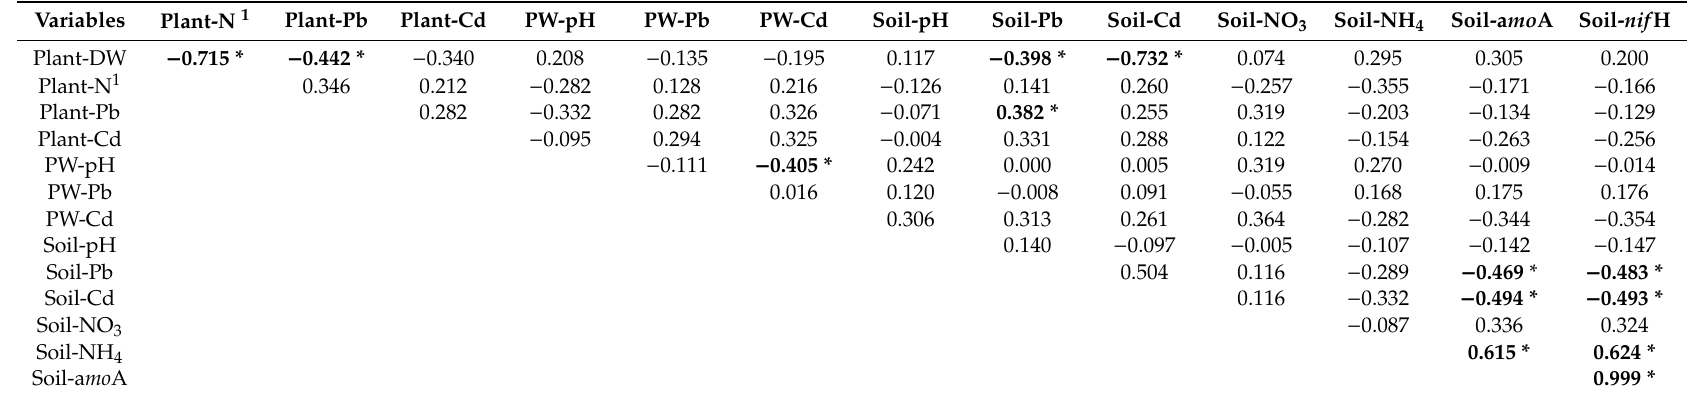
Table 5. Pearson correlation coe ffi cients showing the relationship between soil and plant features for D. glomerata L. (without the unplanted control). The asterisk after values in bold indicate significant correlations at the 0.05 level (2-tailed). PW, pore water.